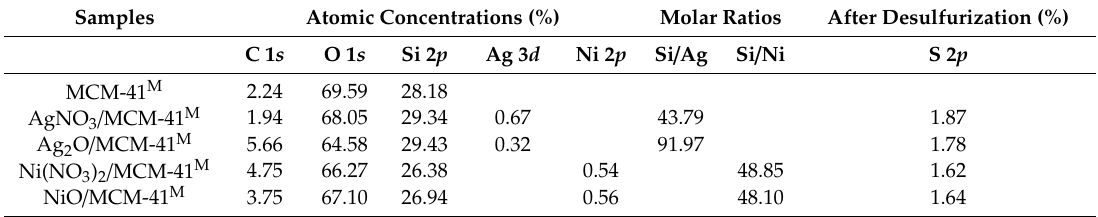
Table 2. Atomic concentrations (%) in the adsorbents surface and Si / metal molar ratio. Samples